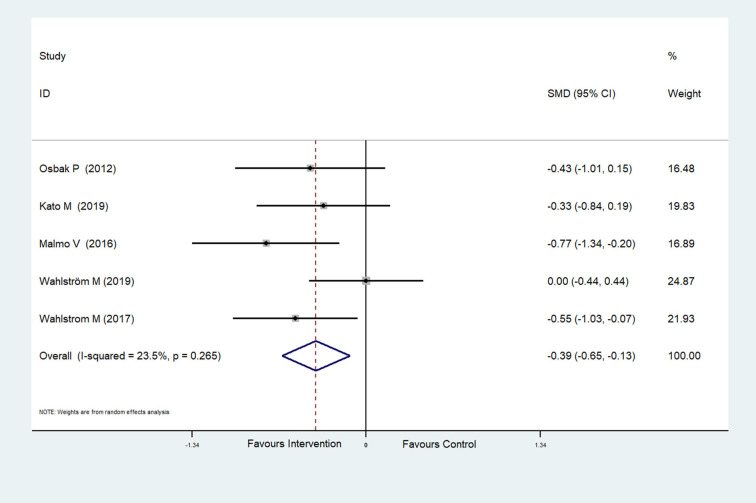
Forest plot shows the ES of physical exercise on resting heart rate in AF patients.